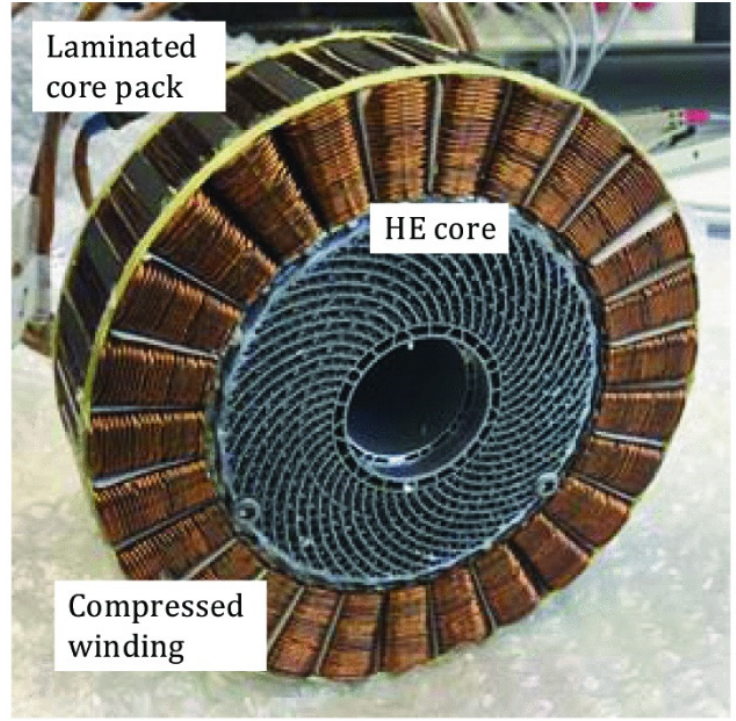
Figure 9. Additively manufactured aluminum alloy heat exchanger for a propulsion motor [70].